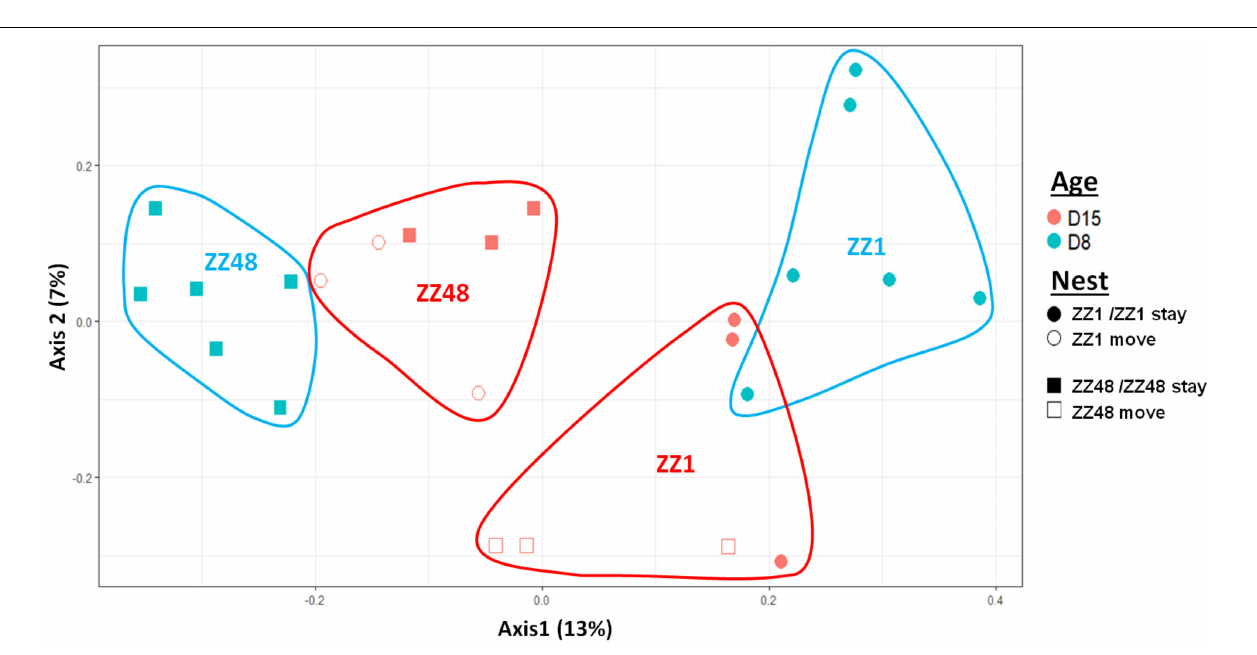
FIGURE 6 | Variation among biological and fostered siblings as indicted by siblings dispersion, that is, the distance of individual nestlings from the centroid of their nest. Median represented by the black line, the mean by the black dot, 25 and 75% quartiles by the lower and upper box and 90% confidence interval by the whiskers. Asterisk refers to statistical differences with p -value < 0.05.